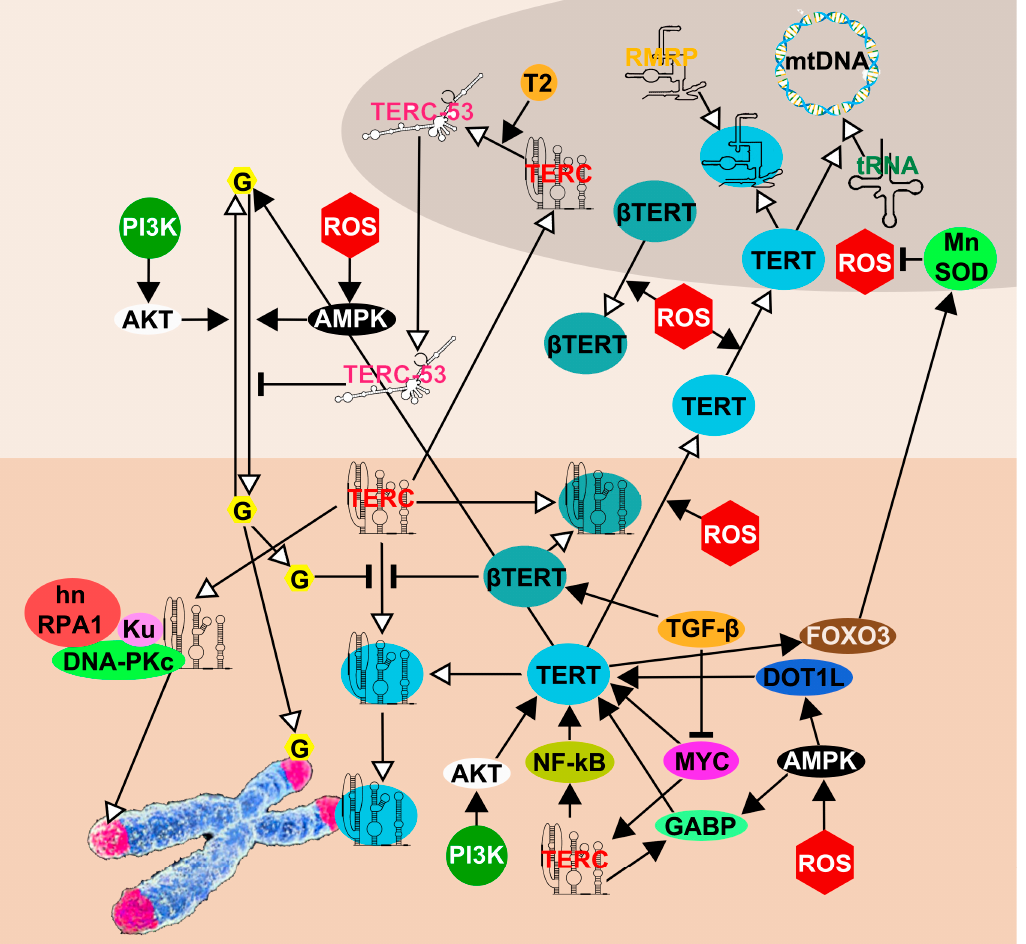
Figure 7. TERT and TERC functions and interactions. PI3K/AKT increase TERT transcription and lead to increased telomerase activity. Moreover, ROS/AMPK increase TERT transcription, but concurrently translocate GAPDH into the nucleus (blocking TERT/TERC) assembly, and translocate TERT to mitochondria (via cytosol), therefore decreasing telomerase activity and increasing non- telomeric functions of TERT. Among these, there is an increase in MnSOD (via FOXO3), which detoxifies ROS, and other mitochondrial functions not yet fully elucidated. G (in yellow hexagons): GAPDH; T2 (in orange circle): RNASET2. For ncRNAs (TERC, TERC-53 and RMRP), secondary structures are shown. Full arrows indicate stimulation, empty arrows indicate translocation.